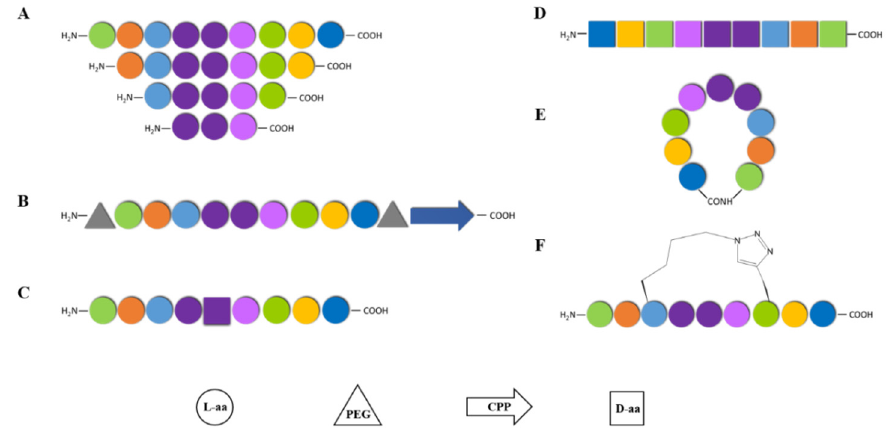
Figure 2. Useful synthetic strategies towards drug-like peptide design: ( A ) Peptide truncation at both N- and C- termini to identify the shortest active amino acid sequence; ( B ) peptide conjugation to PEG and/or CPP to enhance solubility and cell membrane permeation; ( C ) replacement of L- with D-amino acid to improve proteolytic stability; ( D ) retro-enantio approach to achieve a protease-resistant peptide with overall shape resemblance; ( E ) head-to-tail cyclization to increase half-life of peptides; ( F ) Stapling to constrain the peptide into a specific conformation.